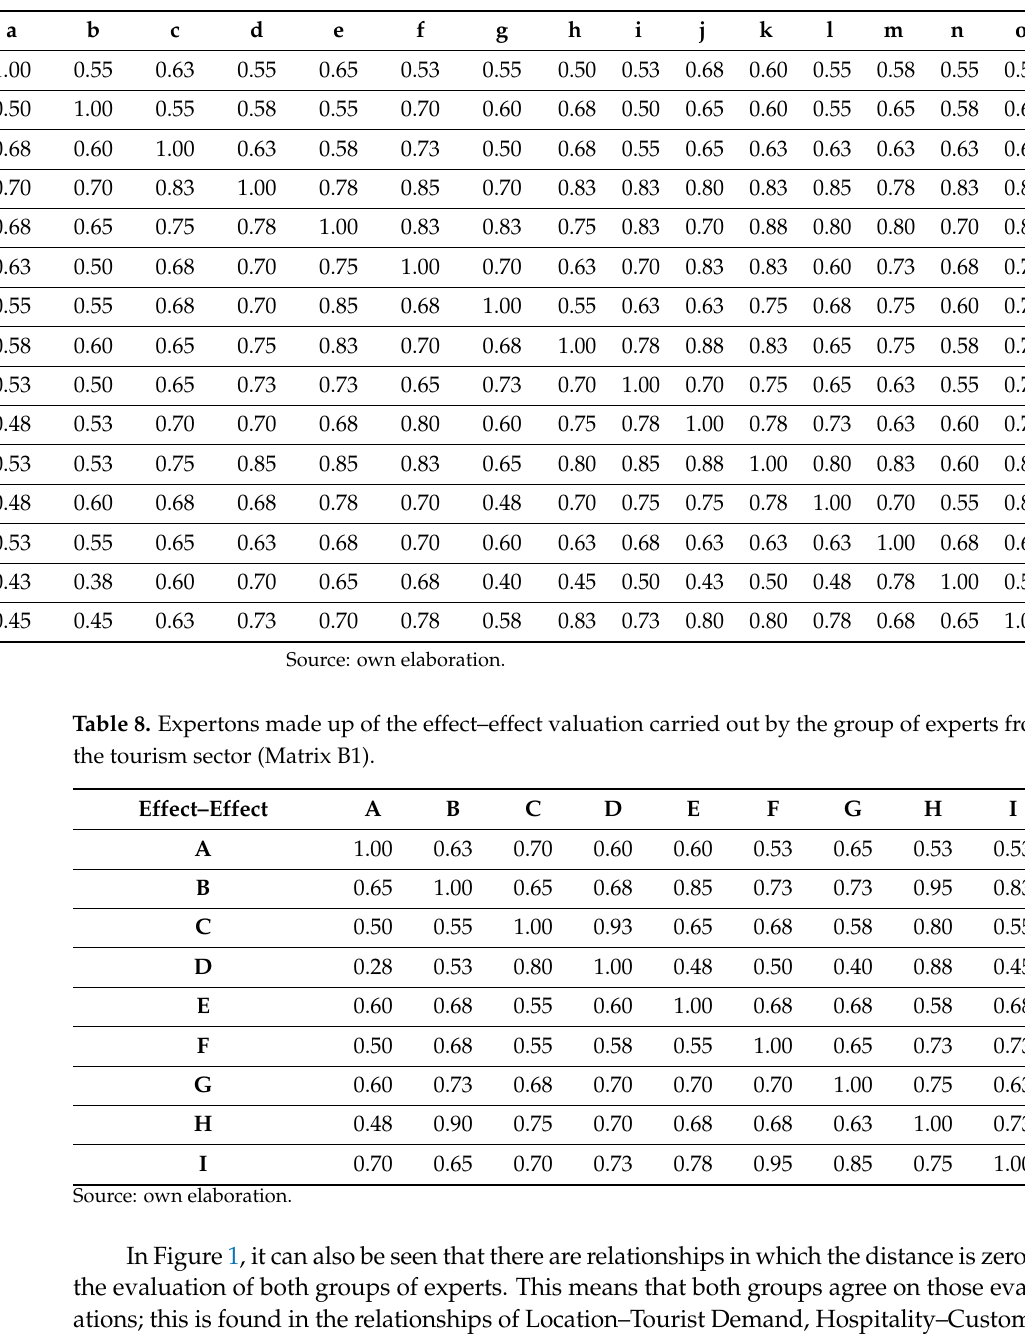
Table 7. Expertons made up of the cause–cause valuation carried out by the group of academic experts/researchers (Matrix A2).